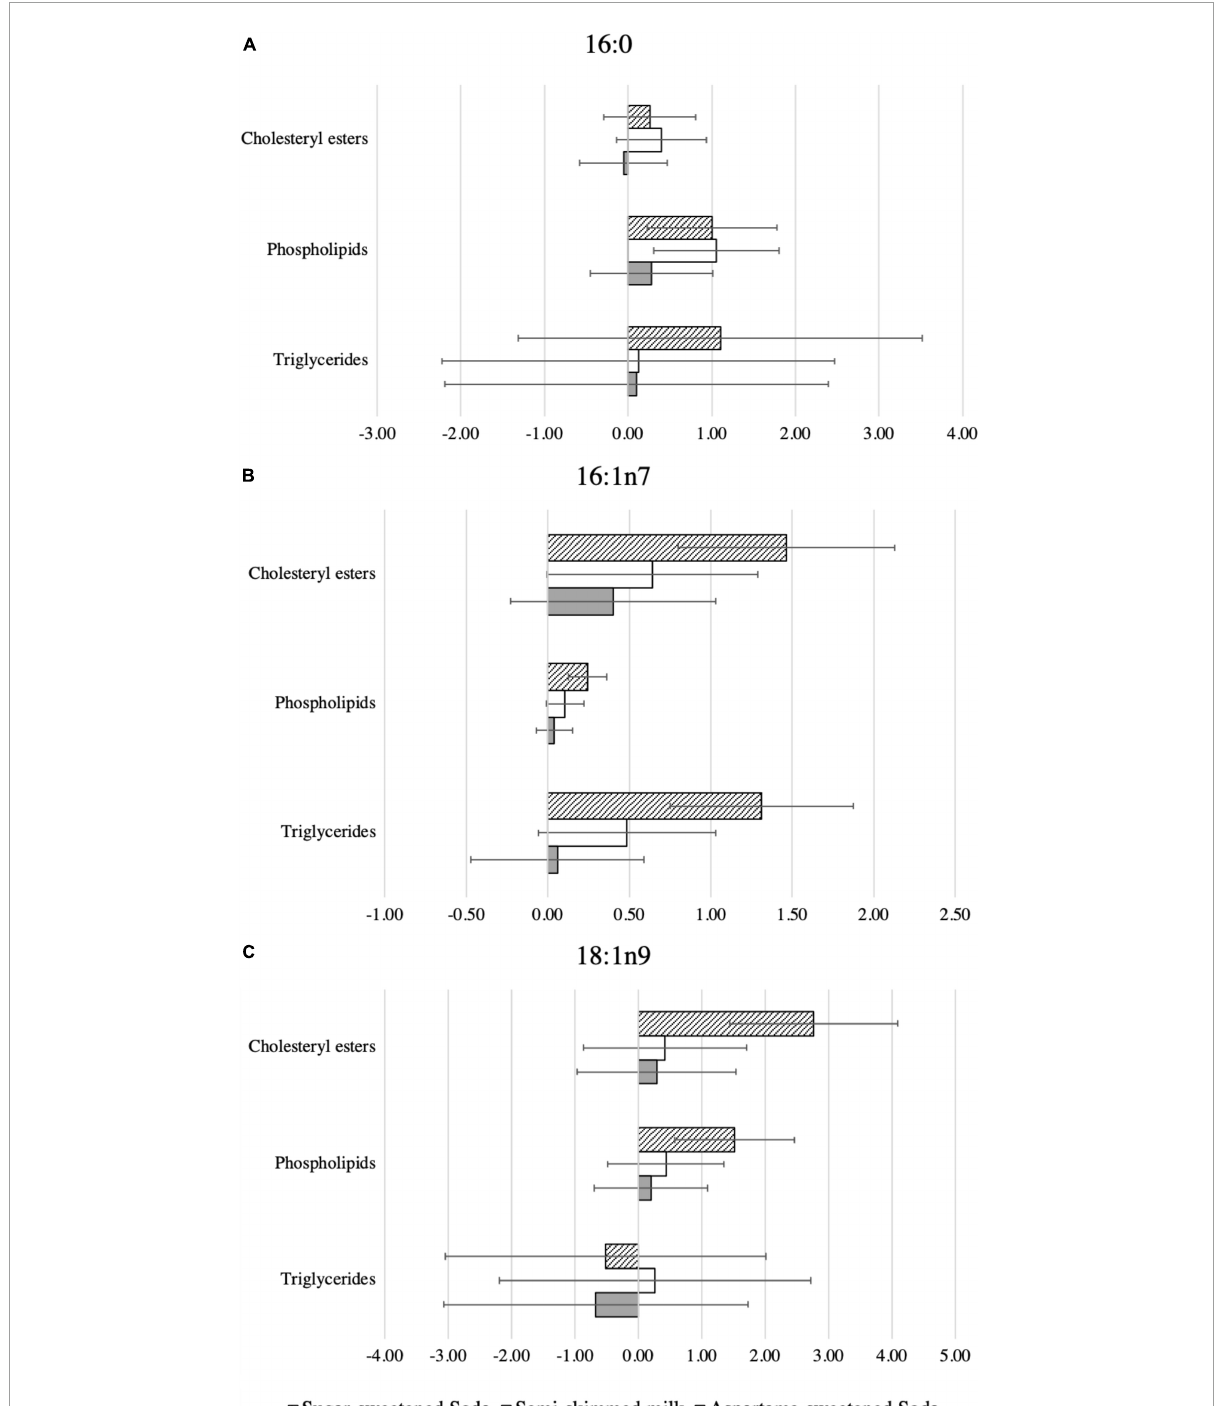
FIGURE2 Data are differences in the relative changes of plasma fatty acids comparing water with each of the test beverages. Percentages of the relative changes as indicated by the mixed effects model, with each individual fatty acid as the dependent variable; individual as a random intercept; group, time, weight, sex, and age as fixed effects; and an interaction term of group and time. (A) Palmitate (16:0), (B) palmitoleate (16:1n7), and (C) oleate (18:1n9). The columns in the charts exhibit the mean values of relative change (the baseline values were subtracted from the 24 weeks values) in the levels of each one of the included fatty acids in each plasma lipid fraction for the included test beverage, in comparison to water. The distinct columns exhibit three test beverages; the diagonal pattern columns represent sugar-sweetened soda, the white columns represent semi-skimmed milk, and the gray columns represent aspartame-sweetened